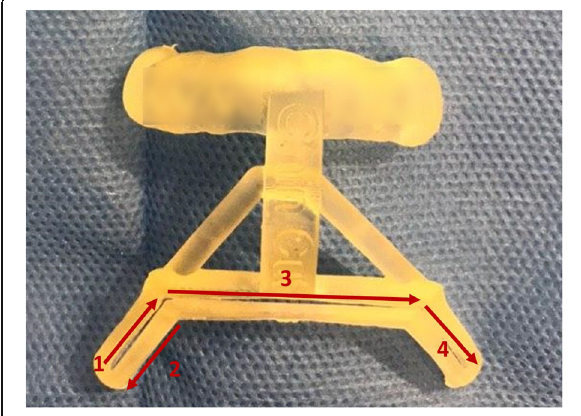
Fig. 1 Steps of chin osteotomy using the surgical guide: (1) The first cut is made in the inclined groove at the opposite side of which the chin is deviated to. (2) The second cut is made along the outer edge of the same side. (3) In the third step, the horizontal cut is made. A bone strip from the side where the chin should be transferred to is available now. (4) By making the fourth cut, the chin is also movable, and by removing the bone strip, it can be transferred to the correct position. Finally, the same bone strip is used for the filling of the gap that was formed on the opposite